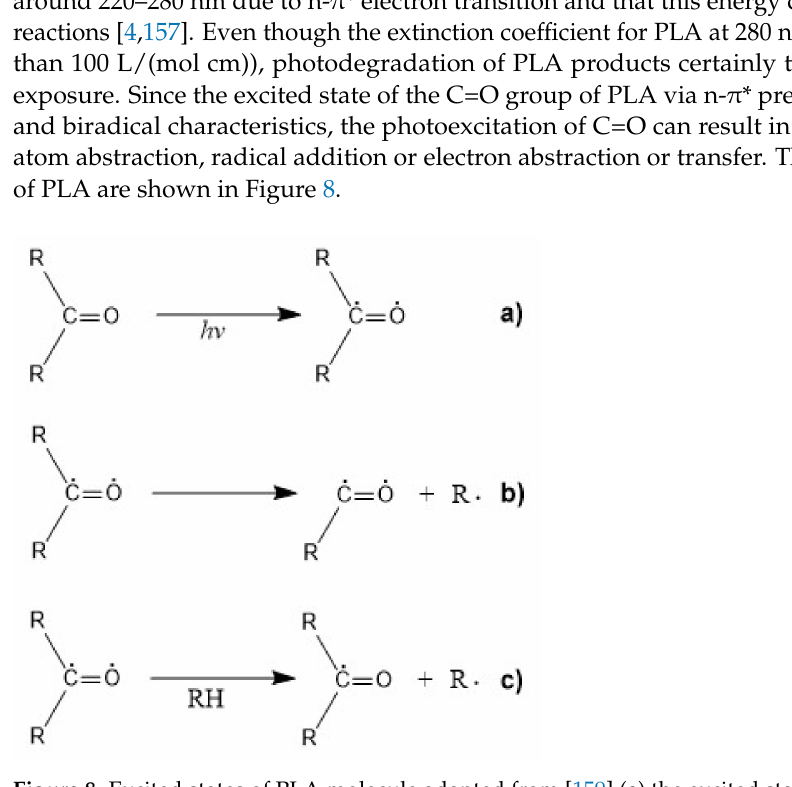
Figure 8. Excited states of PLA molecule adapted from [159] ( a ) the excited state of the C=O group via n-pi* transition exhibits an antibonding and biradical property, ( b ) photoexcitation of C=O tends to cause some chemical reactions, such as bond cleavage or ( c ) radical addition, electron abstraction or electron